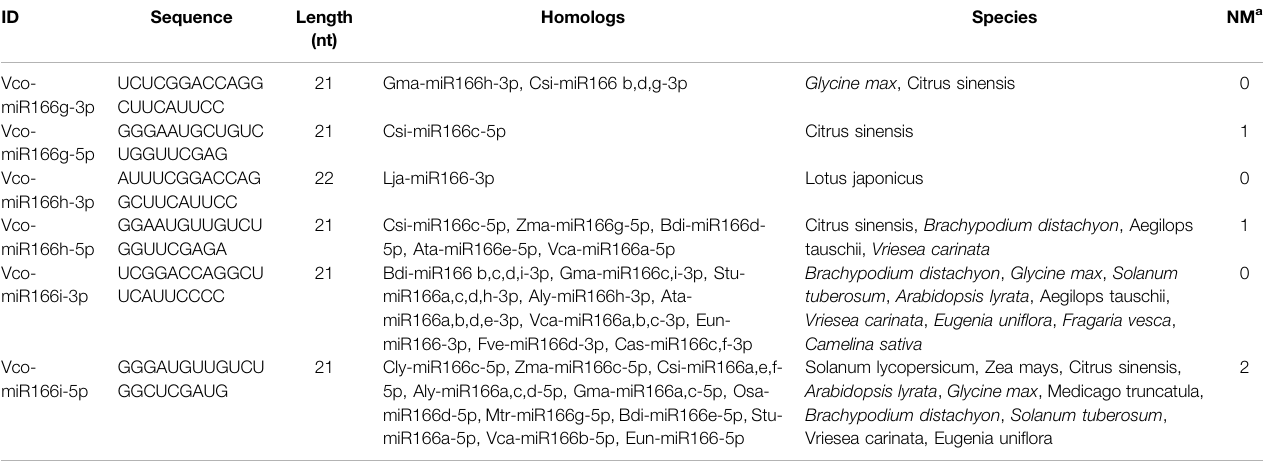
TABLE 2 | Characteristics of six newly identi fi ed mature miR166s in highbush blueberry.